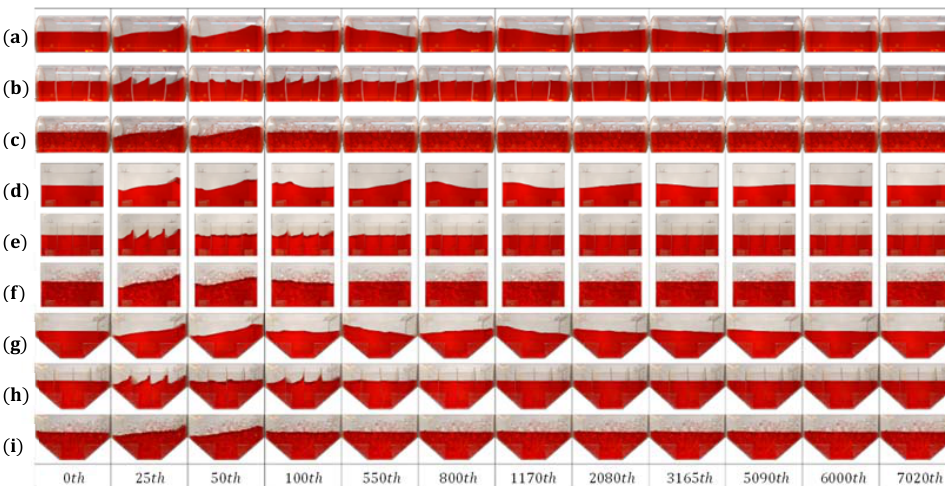
Figure 9. Visual frame observations of slosh effect using high-speed camera at different moments: ( a ) cylindrical tank without baffle, ( b ) cylindrical tank with baffle wall, ( c ) cylindrical tank with baffle ball, ( d ) rectangular tank without baffle, ( e ) rectangular tank with baffle wall, ( f ) rectangular tank with baffle ball, ( g ) hexagonal tank without baffle, ( h ) hexagonal tank with baffle wall, ( i ) hexagonal tank with baffle ball.